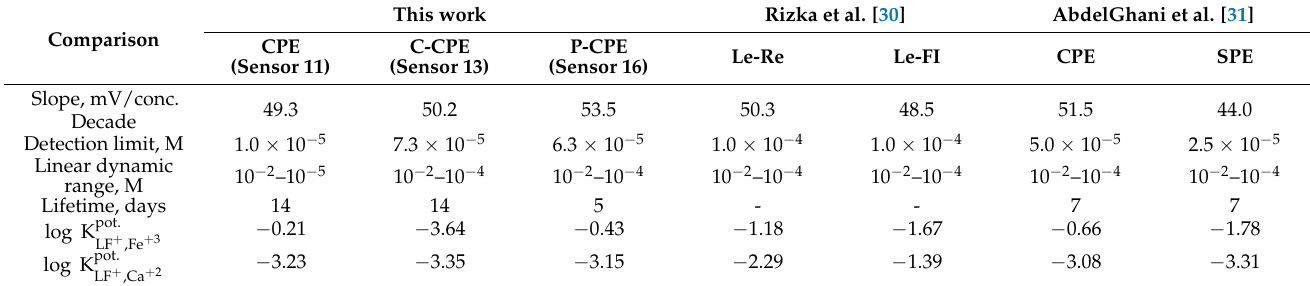
Table 7. Comparison between response characteristics of the best sensors (carbon paste electordes) construcuted in this work and those reportrd by Rizka et al. [30] and AbdelGhani et al. [31]. The electrode compositions (%, wt / wt ) are given in Table